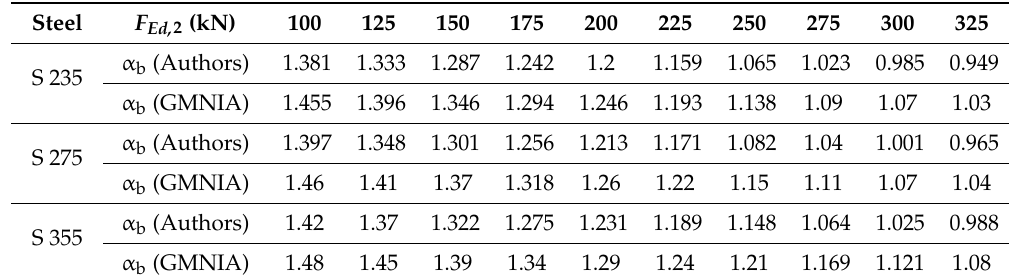
Table 7. Example 5: buckling resistance α b calculated according to the authors’ procedure and with GMNIA.